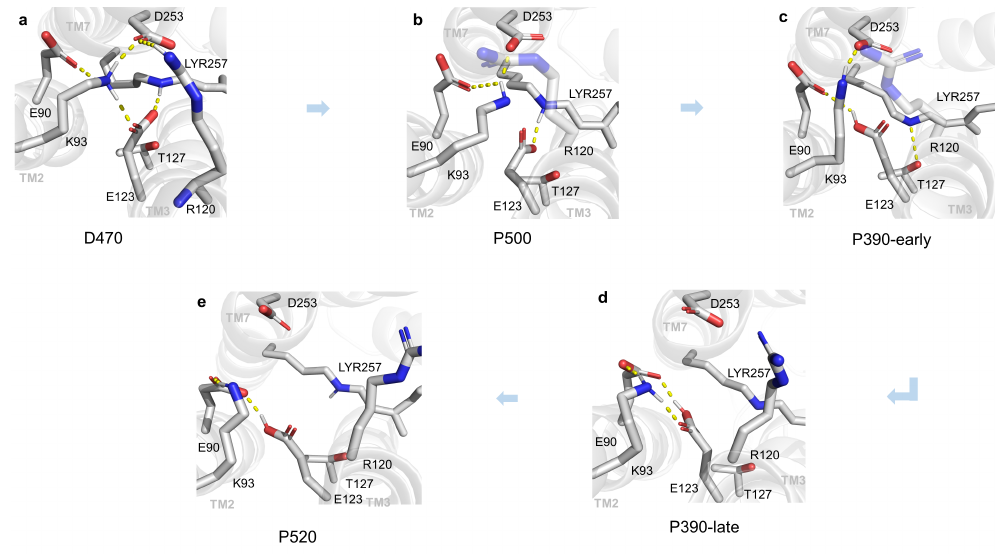
Figure 3. Structural changes of all intermediates in ECG and CG during photocycle. ( a – e ) exhibit the transformation of hydrogen bonding network in ECG and CG from D470 to P520 state and the originally blocked entrance of the ion channel turns into a nearly open pathway. LYR257 is the non-standard amino acid with K257 and retinal covalently-linked. The yellow dotted lines represent hydrogen